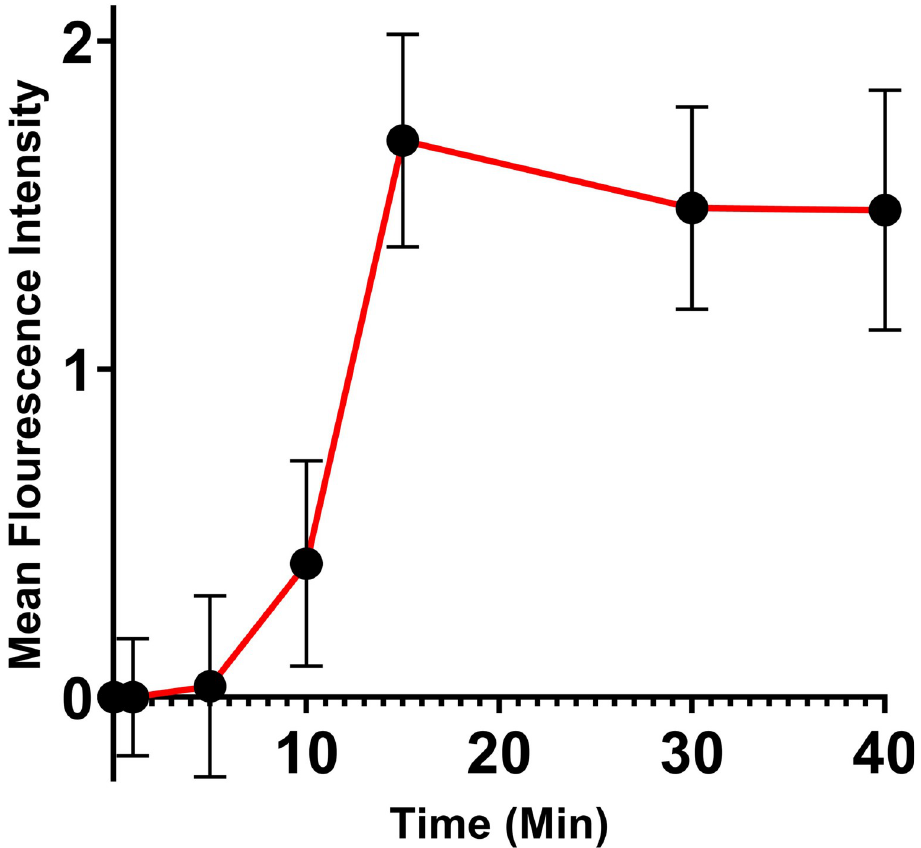
Fig 6. Pulse-chase cell-penetration assay. Quantification of Pulse Chase CPP Mediated Cargo Delivery in BHK21 Cells. WT TAT-NMRCaM and CBS-MBP were delivered at a concentration of 400nM for 10 minutes. Experiments completed to N = 3. Mean intensity values were averaged across all three movies. Errors bars were calculated from Standard Error of the Mean for each timepoint and were averaged across all three movies. Quantification performed using Fiji (ImageJ) software. Intracellular fluorescent signal was calculated and subtracted from extracellular background signal present at each timepoint. The red line is meant to be an aid for the eyes and does not indicate any fit to the data. Error bars represent S.E.M. for each